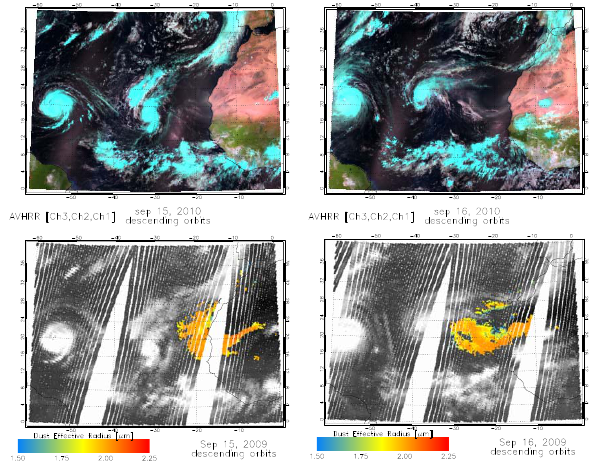
Fig. 6. IASI observations of Dust AOD 0.5µm (colours) and IIS temperature (greyscale) from 14 September afternoon through morning 16 September 2010.